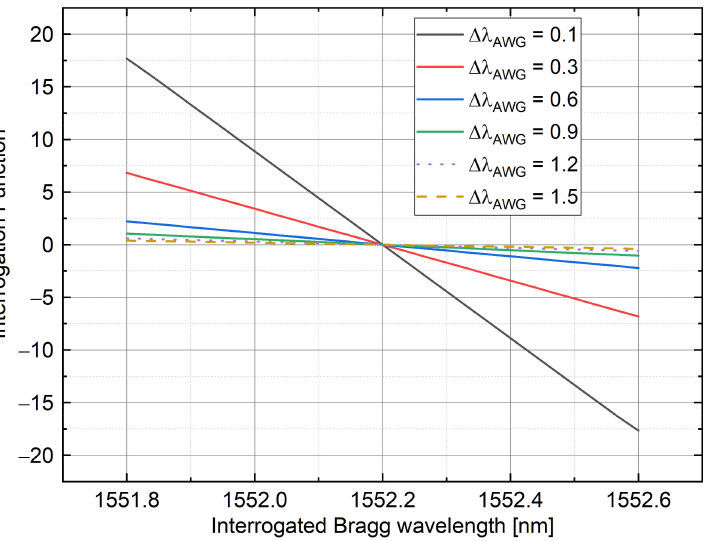
Figure 7. Interrogation function variation versus FBG wavelength for different AWG channel band- width values